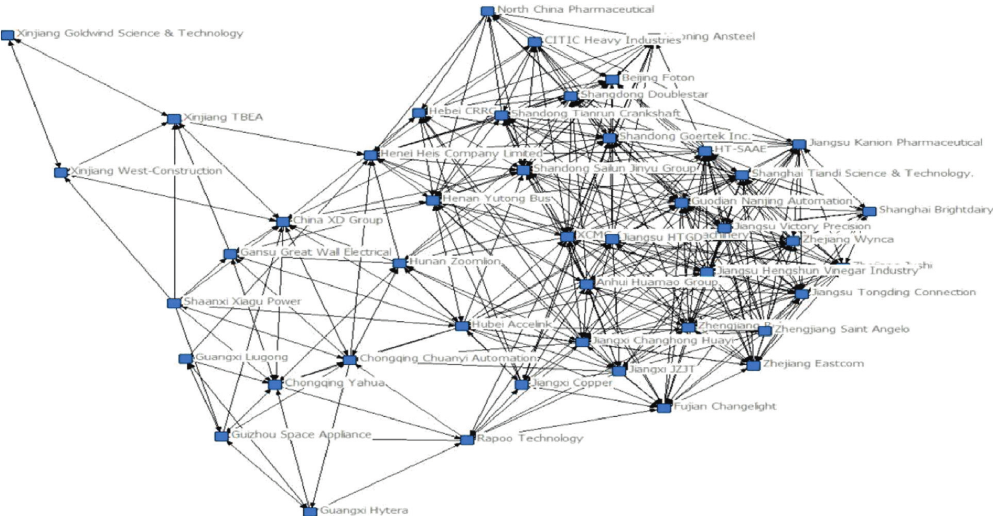
Figure 2: Spatial correlation network of the innovation efficiency of the IM enterprises in